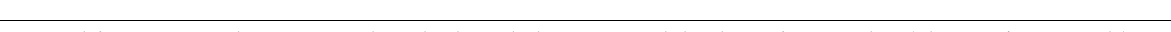
Fig. 9 Osr1 -de fi ciency impairs the myogenic niche in developing limbs. a Decreased abundance of COL6 and FN (Fibronectin) in proximal (inserts 1 and 3) and dorsal (inserts 2 and 4) muscle primordia of Osr1 -de fi cient E11.5 limbs. Boxed regions are shown in the numbered panels to the right and are magni fi cations of the area. b Reduced abundance of interstitial FN and disarrangement of COL14 in E13.5 Osr1 GCE/GCE limb muscles as compared to wild- type littermate controls. c Extracellular matrix (ECM) produced by Osr1 GCE/+ cells, but not ECM produced by Osr1 GCE/GCE cells supports myoblast proliferation ( n = 3). d E11.5 Col6a1 − / − embryos show a decrease in myogenic progenitor numbers ( n = 3). e Transwell assay shows a bene fi cial effect of E13.5 Osr1 GCE/+ embryonic FAPs (eFAPs) but not Osr1 GCE/GCE eFAPs on myogenesis. Transwell culture without eFAPs was used as control ( n = 3). f Cxcr4 − / − embryos show muscle defects overlapping with Osr1 GCE/GCE embryos. g Sections of Cxcr4 +/+ and Cxcr4 − / − embryos show almost complete reduction of the biceps femoris anterior head and hypoplasia of the biceps femoris accessory head. h Decreased phosphorylated ERK (pERK) and ( i ) CyclinD1 in myogenic Lbx1 + cells in E11.5 Osr1 mutants ( n = 3). j Schematic model of Osr1 + cell function. Osr1 + cells (green) produce chemokines as Cxcl12 and a speci fi c extracellular matrix (ECM) supporting myoblast proliferation and survival involving pERK signaling. Cxcl12 in addition likely provides local migratory cues ensuring correct spatial distribution of myoblasts as a prerequisite for muscle patterning. k Schematic model of limb muscle connective tissue compartmentalization. Speci fi c transcription factors (Osr1 and Tcf4 are shown as examples) are expressed regionally in the limb bud with areas of overlap creating a regionalized code that likely determines the composition of the local niche. Error bars represent s.e.m. T-test: * = p < 0.05; ** = p < 0.01; *** = p < 0.001. N-numbers indicate biological replicates, i.e. samples from different specimen in d , h , i or independent assays in c ,